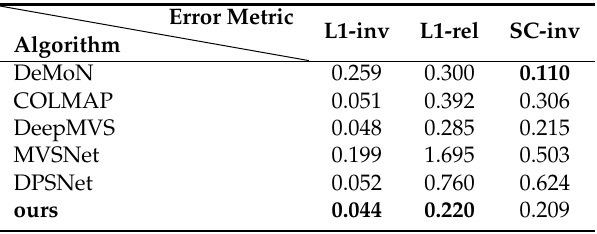
Table 1. Quantitative comparison of different algorithms on the ETH3D dataset. The best value is highlighted in